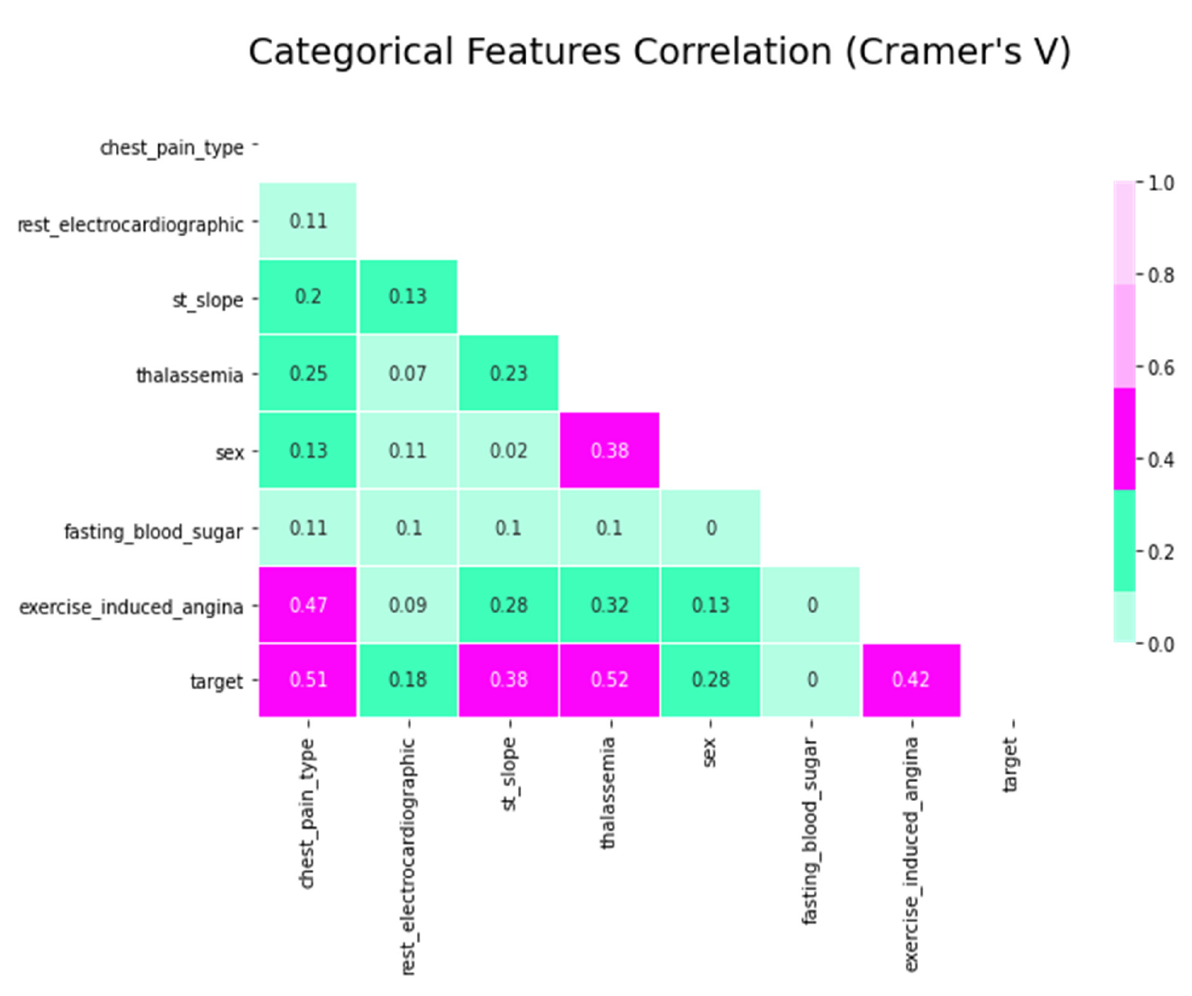
Figure 11. Categorical features correlation (Cramer’sV).